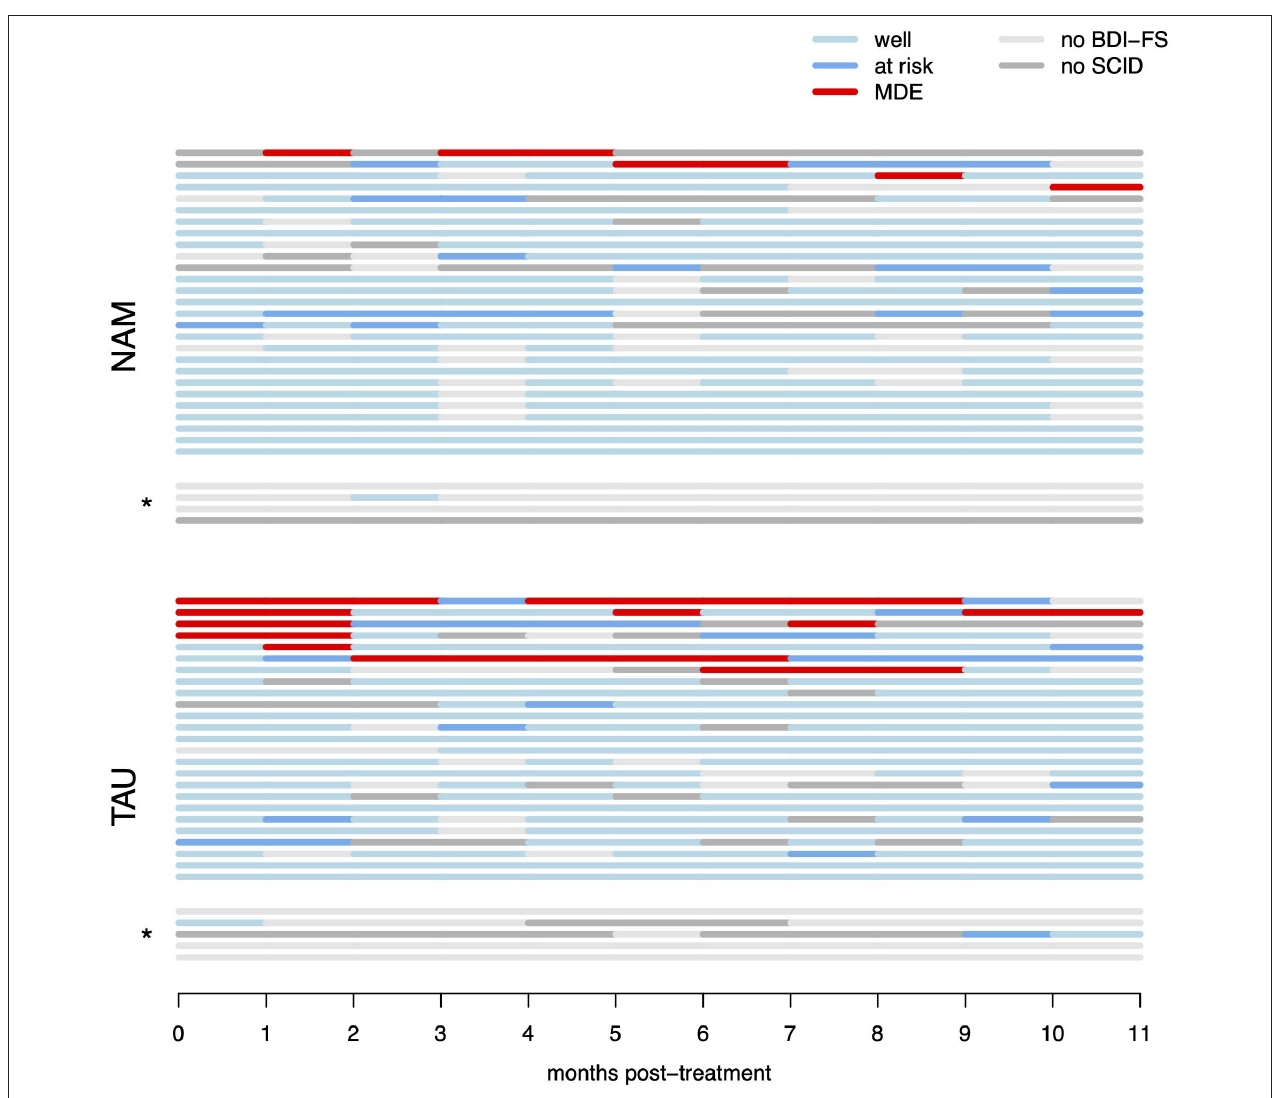
FIGURE 2 | Raw survival data (monthly per-participant data regarding recurrence of MDD). “Well” denotes months with sub-threshold BDI-FS scores (and no diagnostic interview performed), “at risk” denotes months with elevated BDI-FS scores, but criteria for MDE were not met in the diagnostic interview, “MDE” denotes months with elevated BDI-FS scores and diagnosis of major depressive episode in the diagnostic interview by telephone. “No BDI-FS” denotes months for which BDI-FS data could not be obtained, “no SCID” denotes months with elevated BDI-FS scores, but participants could not be reached for the diagnostic interview. *indicates participants with < 3 months of available monthly data, which were excluded from the multiple imputation analysis (but included in the raw data ITT survival analysis).